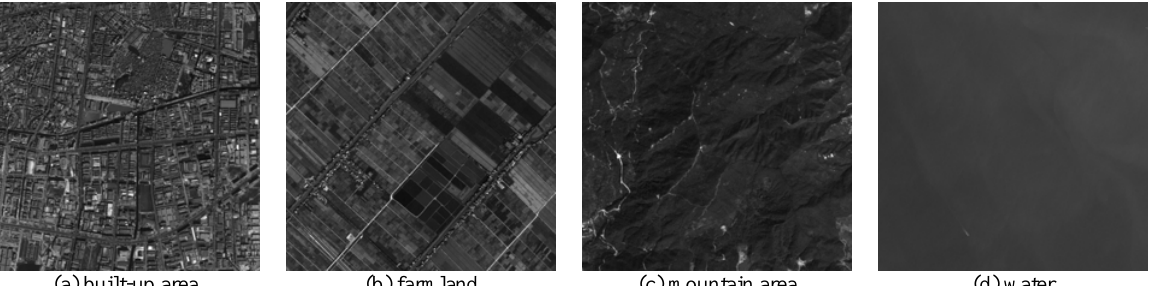
Figure 5. Remote sensing images of for typical land cover types